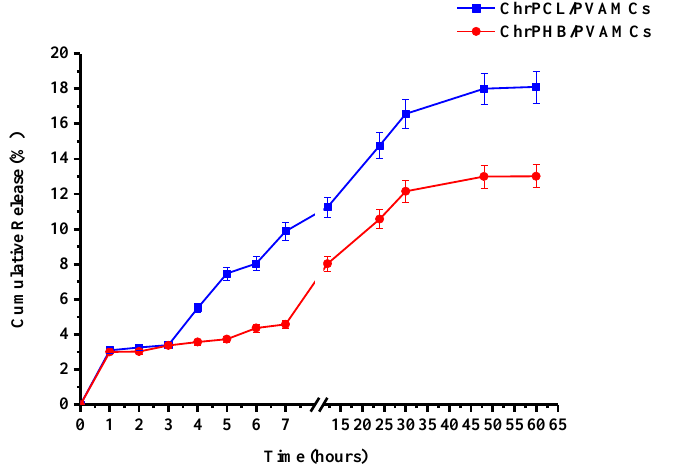
Figure 5. Cumulative release percentage of chrysin with regard to the total entrapped chrysin vs. time for ChrPCL/PVAMCs (blue line) and ChrPHB/PVAMCs (red line). Table 1 summarizes the results of the physico-chemical characterization of the produced empty and chrysin-loaded micro-formulations. d FESEM a Table 1. Physico-chemical characterization data of the produced empty and chrysin-loaded micro-formulations. Micro-formulation Micro-